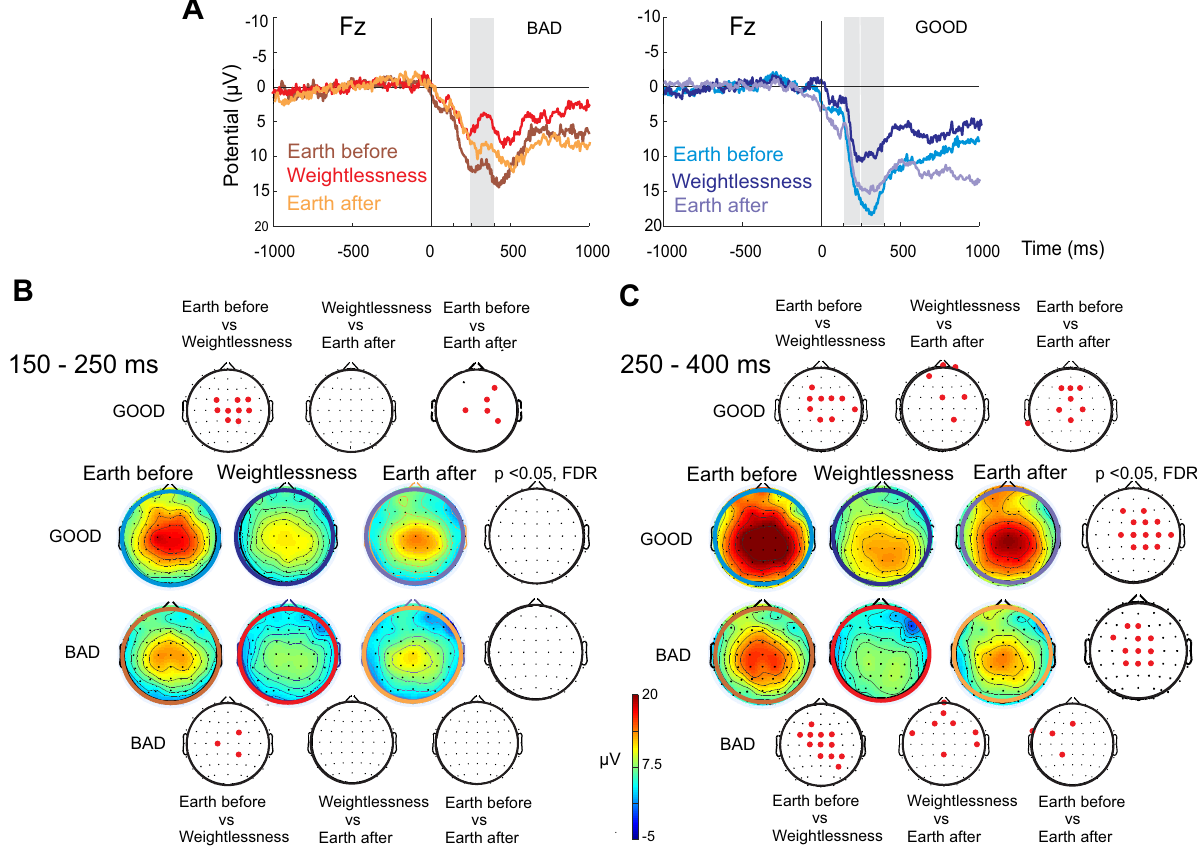
Figure 4. ERPs and topographical voltage distribution for the BAD and GOOD dockings (and related visual feedback: spaceship center yellow or blue colored). ( A ) ERPs for the BAD (on the left) and for the GOOD (on the right) dockings across the three conditions. Bars colored in grey are placed during the periods of interest (250–400 ms on the left; and 150–250 ms and 250–400 ms on the right). ( B ) and ( C ) Topographical voltage distribution of the GOOD and BAD dockings and statistical (permutations, FDR corrected) contrasts for the 150–250 ms (on the left) and 250–400 ms (on the right) periods of interest. Note that the topographical voltage distribution consistently changed in the central area before (in the 150–250 ms period) for the GOOD but not for the BAD dockings when comparing Earthbefore versus Weightlessness. There were no changes between Weightlessness and Earthafter conditions. ( C ) Both GOOD and BAD topographical distributions were modified from Earthbefore to Weightlessness, from Weightlessness to Earthafter and when comparing Earthbefore versus Erathafter in the 250–400 period. In ( B ) and ( C ) colorful circles around the scalp topographies keep the same color code that ERP traces in ( A